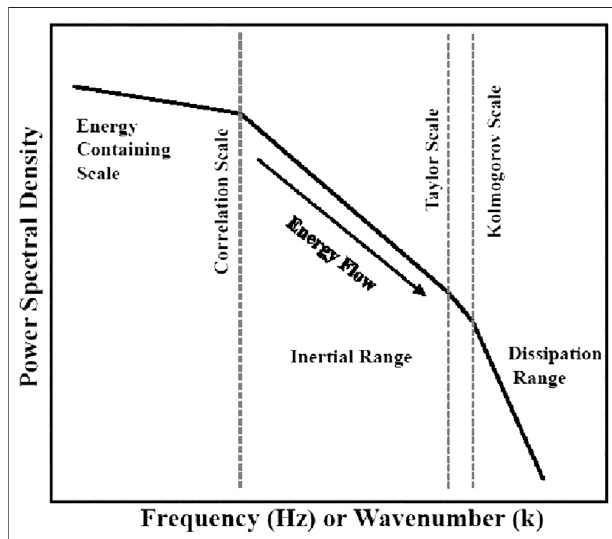
FIGURE 1 | Schematic of a typical power spectral density plot for turbulent solar wind. The lowest frequencies are at the energy containing scales and the dissipation range is at the highest frequencies. The correlation scale(leftmostdashedgrayline)separatesenergycontainingscalesand the inertial range while the Kolmogorov scale (right most dashed gray line) is between the inertial range and the dissipation range. The third scale on the schematic is the Taylor scale (middle dashed gray line), the scale at which eddies start to damp out, (Adapted from Goldstein et al.